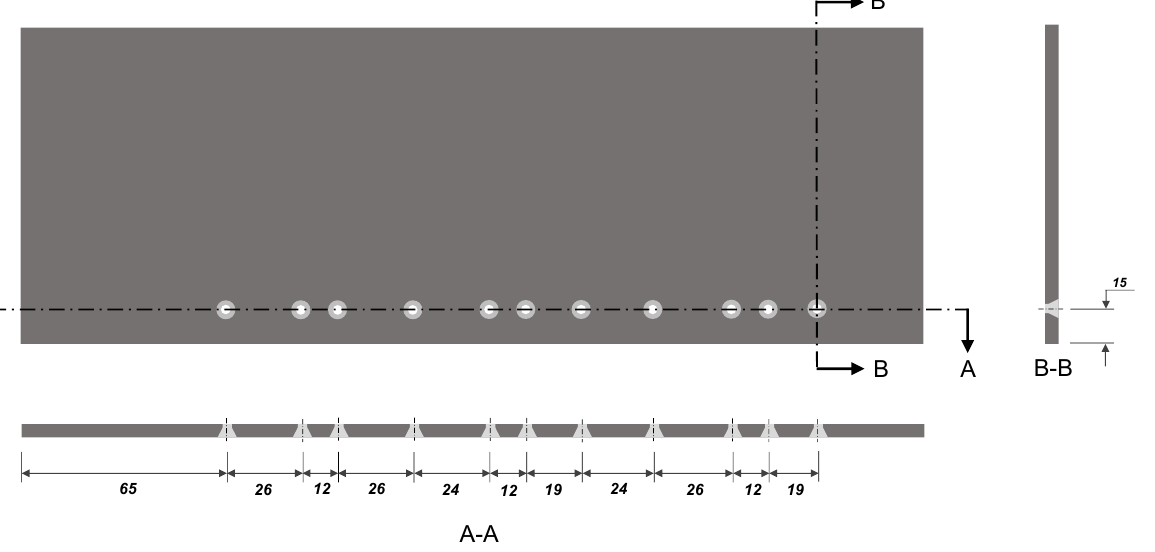
Figure 2. Scheme of the geometry and the relative position of the profiles drilled in titanium sheets (back view). All dimensions in mm.